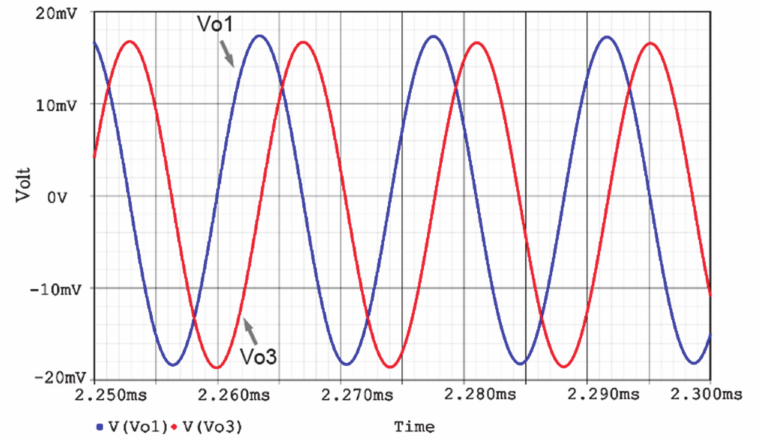
Figure 23. The steady-state simulation waveform of the quadrature voltage outputs.